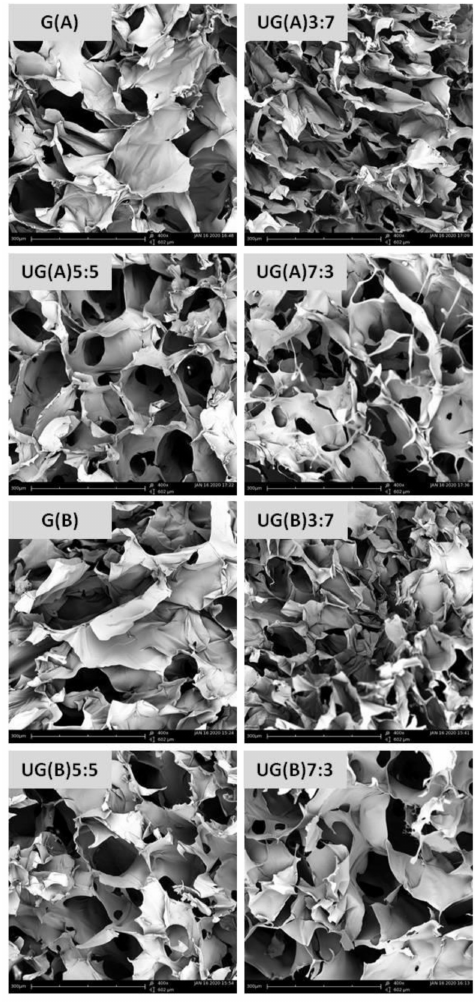
Figure 2. SEM images of UG hybrid sca ff olds prepared under acidic or basic conditions and with varying ulvan to gelatin weight